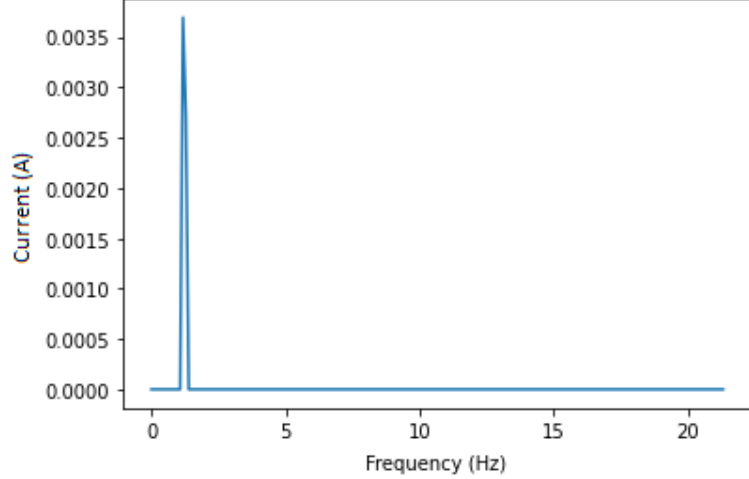
Figure 7. Squared envelope of faulty IM after threshold.